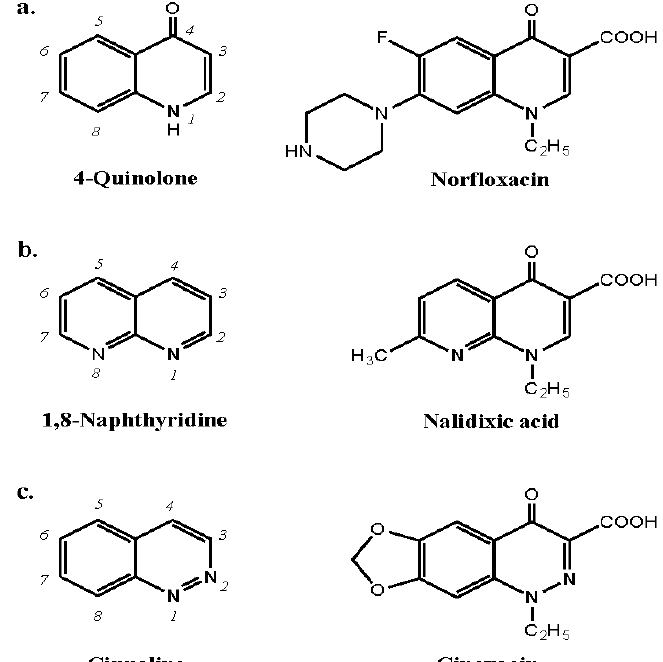
Figure 19. Structures of the broad family of quinolone antibacterial drugs based on the 4-quinolone, 1,8-naphthyridine and cinnoline nuclei together with examples of a drug from each class, viz ., norfloxacin, nalidixic acid and cinoxacin,